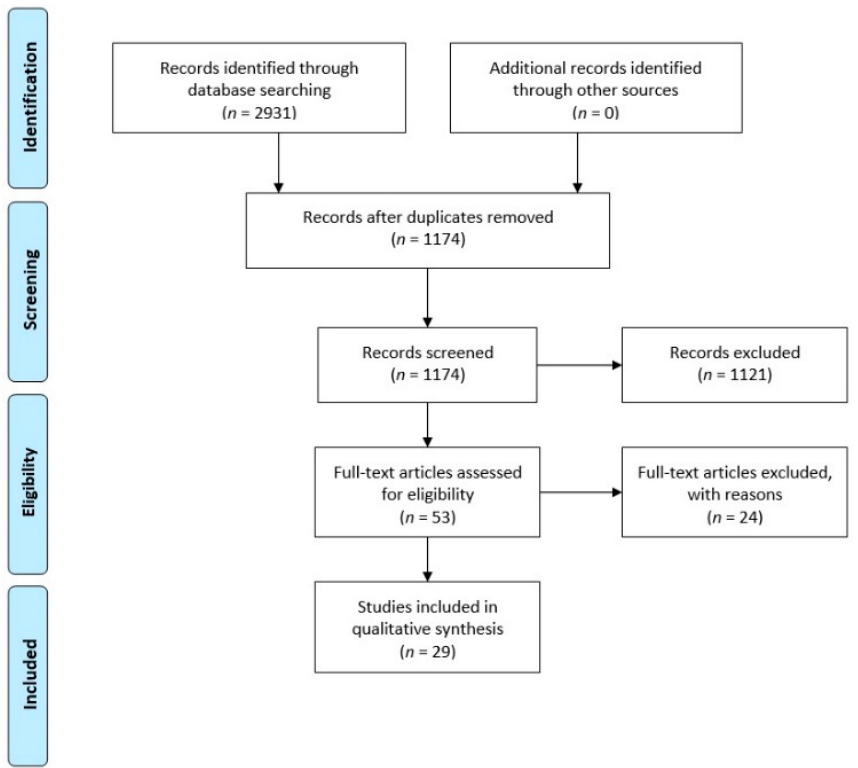
Figure 1. Flowchart of literature search.